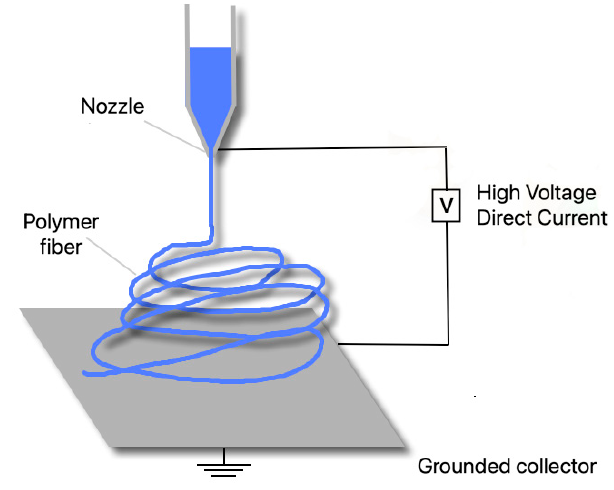
Figure 4. The basic components of electrospinning.